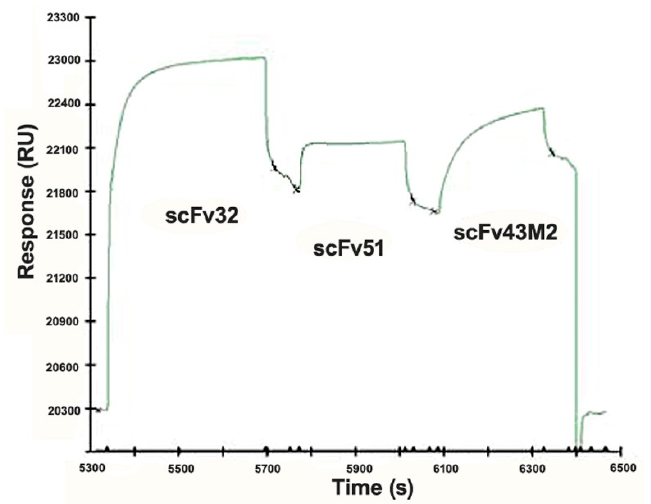
Figure 3. Surface Plasmon Resonance (SPR) analysis of the anti-16E7 scFv32, scFv43M2 and scFv51 binding to the 16E7 protein. The sensorgram shows the relative binding of the three scFvs to the recombinant 16E7 immobilized on the sensor chip. ScFv32 at saturating concentration was injected, followed by scFv51 and then by scFv43M2.